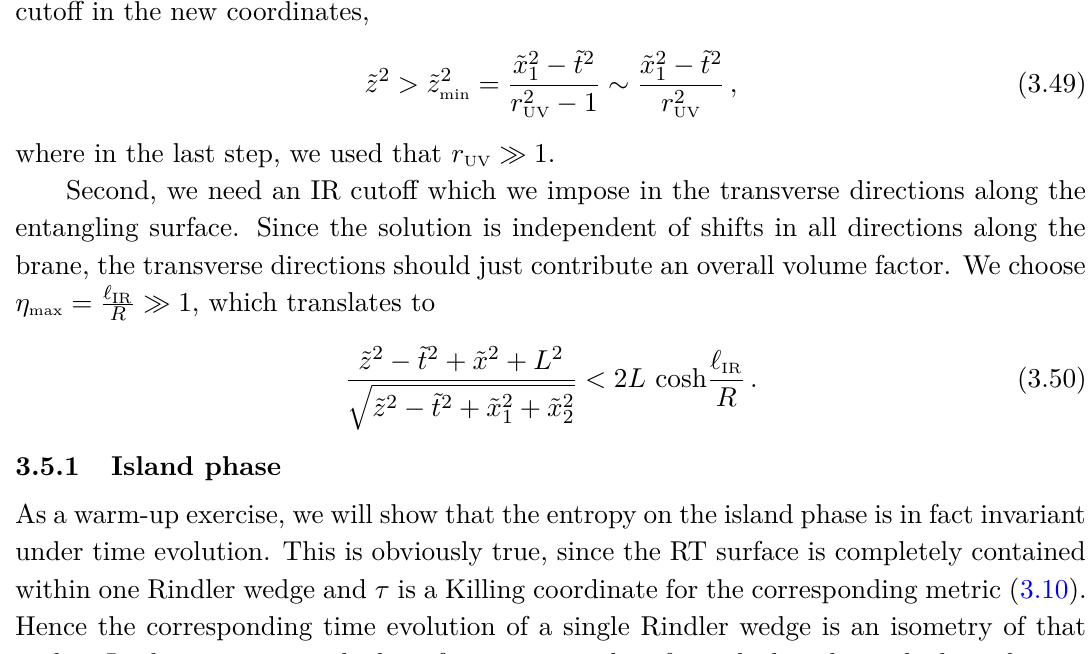
Figure 12. The left panel shows two components of the entangling surface (red) at non-zero Rindler time τ Σ in the right CFT in the Poincaré coordinates (3.47). In the island phase, these two rays in the boundary geometry are connected by an RT surface in the bulk. We can perform a boost in ˜ x 1 direction to map this set of entangling surfaces to the t = 0 slice, which also corresponds to τ = 0 slice of the hyperbolic boundary geometry. The boost is a symmetry of the defect (green). maximum radius in both AdS-Rindler patches r (cid:29) 1 . This translates to a ˜ z -dependent UV cutoff in the new